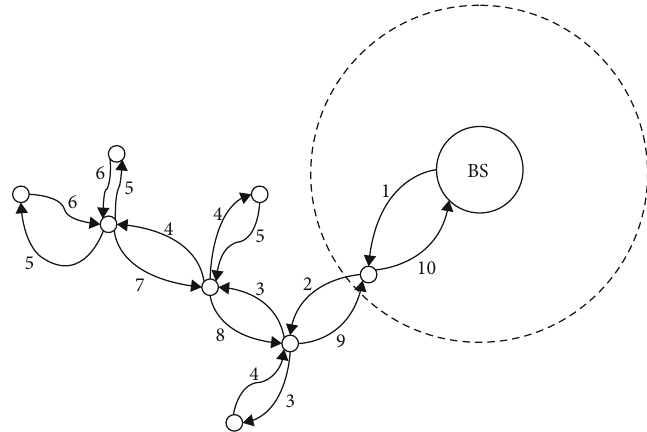
Figure 2: Propagation of the “ Hello ” packet and replies from the nodes.